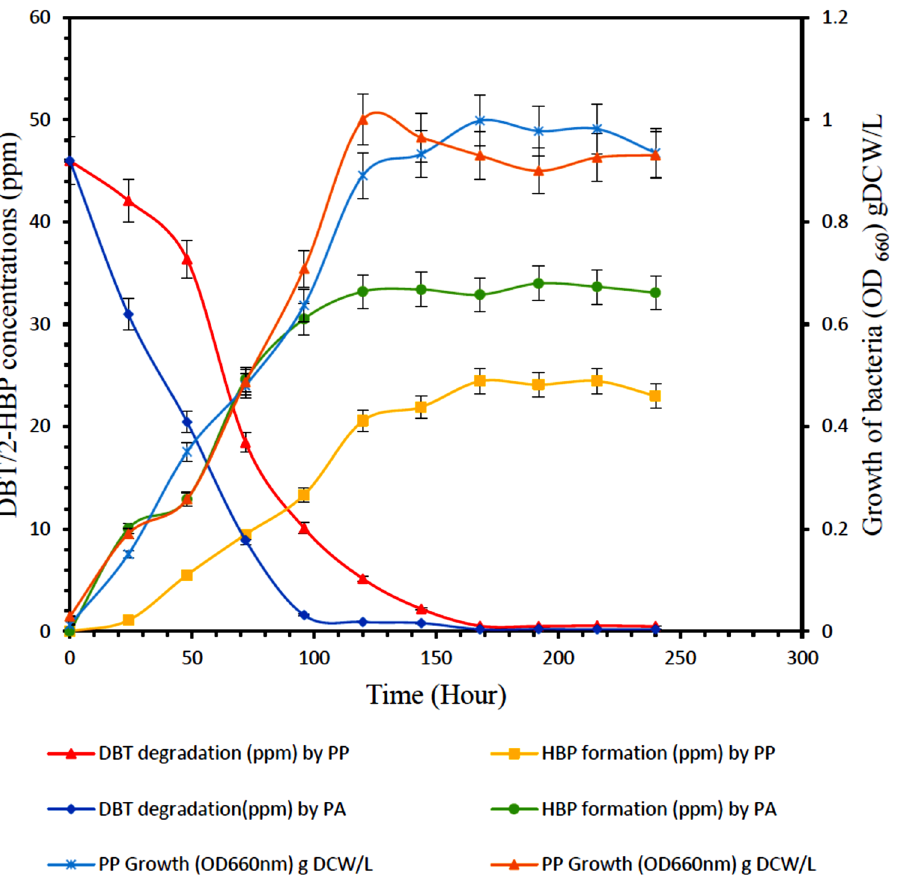
Figure 1. Cell growth of Pseudomonas aeruginosa and Pseudomonas putida with DBT degradation and 2-HBP formation. Experimental conditions: Initial DBT concentration 46 ppm, Temperatures 30 °C and 37 °C for Pseudomonas aeruginosa and P seudomonas putida , respectively, Shaking speed 130 rpm.